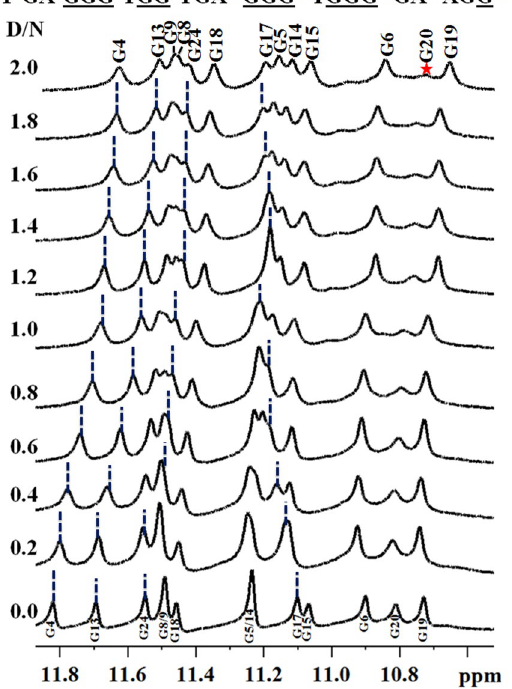
Figure 5. Imino region of one dimensional proton spectra for Quercetin - Pu24T complex. 1 H NMR spectra showing the interaction of Quercetin with Pu24T monitored by imino region as a function of D/N ratio at 298 K (Changes in the chemical shift for G4, G13, G24, G17 were followed by blue dotted lines from D/N = 0.0 to D/N = 2.0 and broadening of G20 was marked as asterisk).